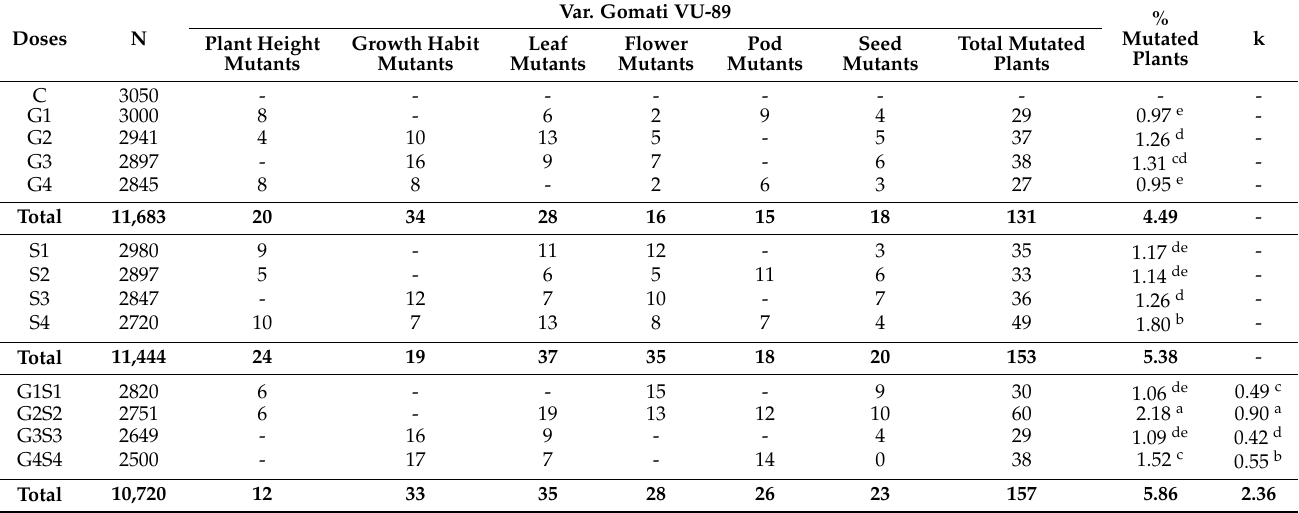
Table 5. Frequency and spectrum of morphological mutants in cowpea varieties Gomati VU-89 and